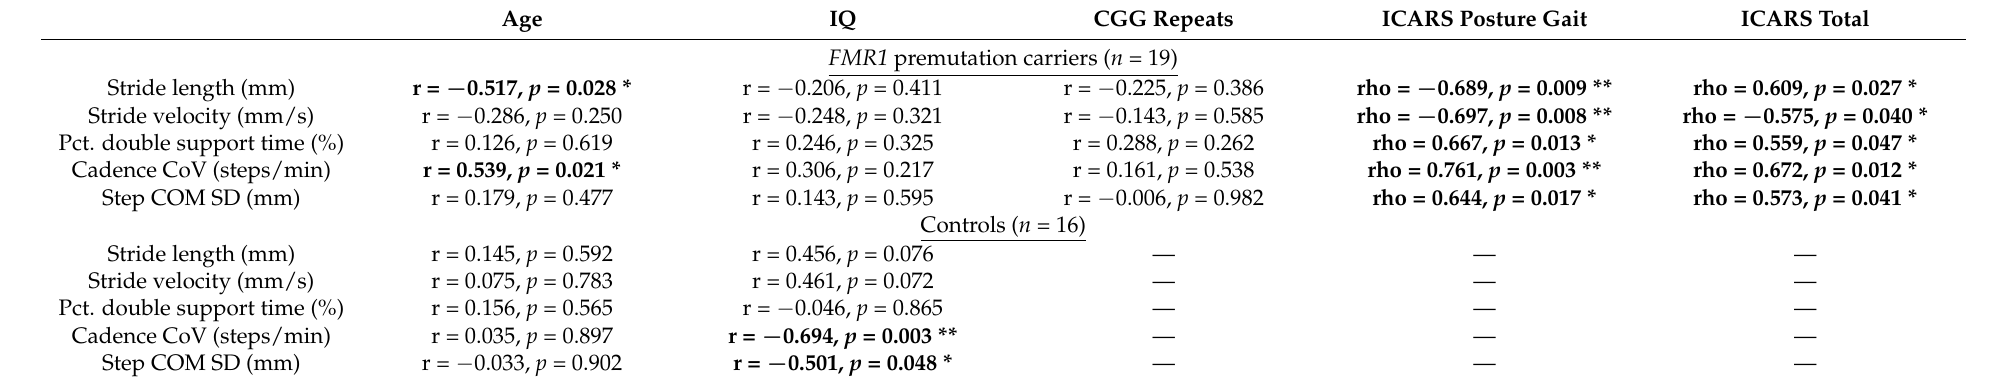
Table 4. Correlations between gait features and demographic and clinical characteristics for premutation carriers and